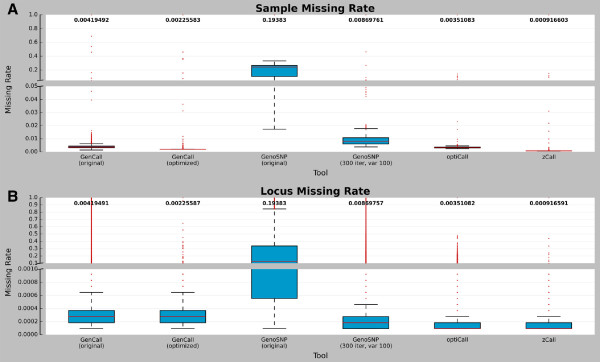
Locus and sample missing rate. Boxplots showing the distribution of (A) locus and (B) sample missing rates. Values closer to 0 (100% completeness) are preferable. Rates are shown for each of the six tools: GenCall (original and optimized cluster files), GenoSNP (original and optimized), optiCall (without excluding markers failing Hardy-Weinberg) and zCall. The median is shown with a red line and the mean is indicated above each plot. The red dots represent outliers according to the interquartile range. The rates are shown for 10,856 samples and 247,590 markers (markers located on chromosome Y were excluded).